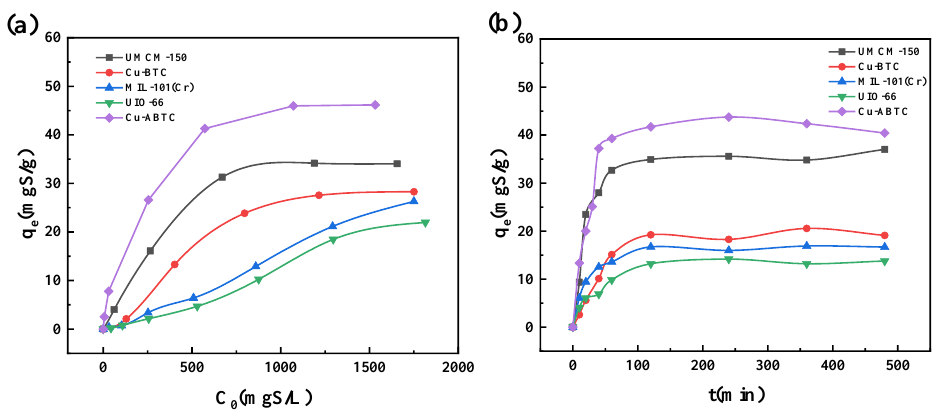
Figure 4. The adsorption performance of the five MOFs ( a ) under various sulfur concentration; ( b ) under different adsorption time. (T = 30 °C, oil-adsorbent ratio = 70 g/g).